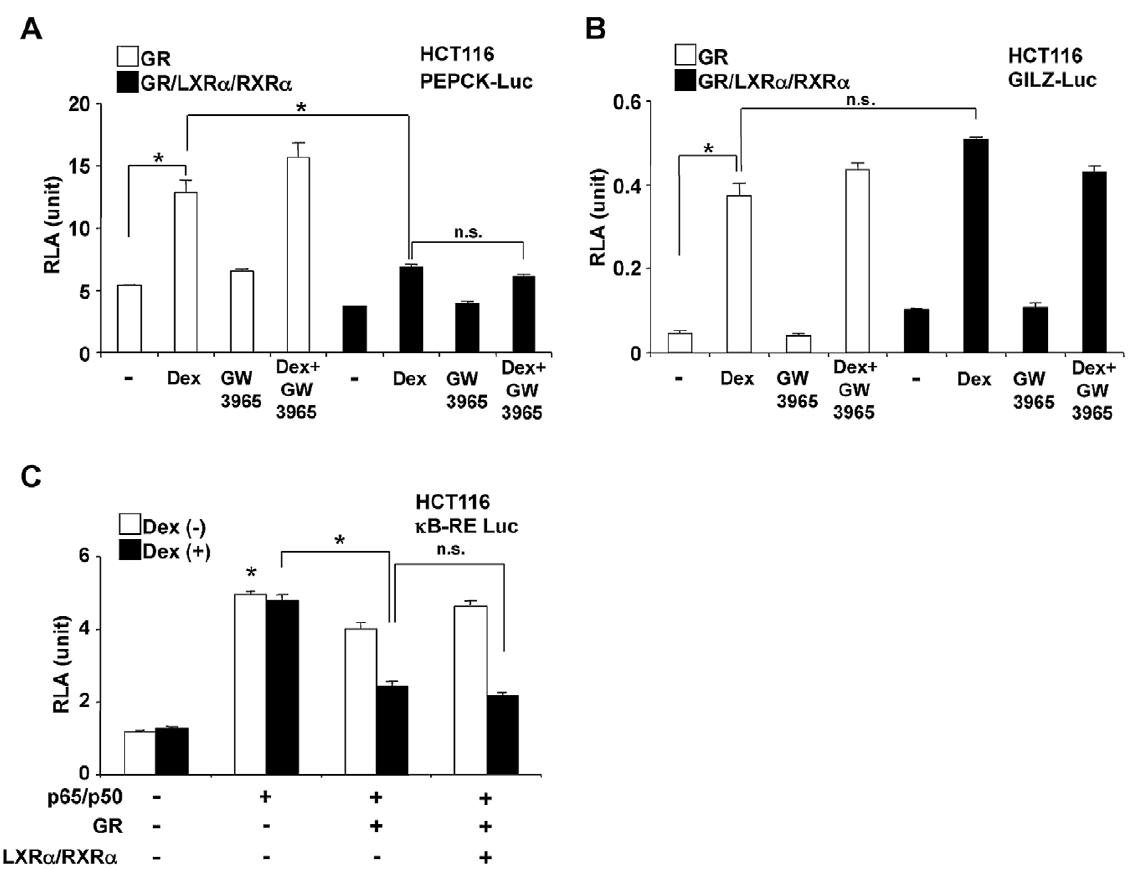
Figure 2. Over-expression of LXR a regulates dexamethasone-stimulated GR transcriptional activity in a gene promoter-specific way. A and B. Over-expression of LXR a /RXR a suppresses dexamethasone-stimulated transcriptional activity of the PEPCK (A) but not the GILZ (B) promoter. HCT116 cells were transfected with pPEPCK-luc (A) or pGILZ-Luc (B), together with pGL4.73[ hRluc /SV40] and pRShGR a in the presence or absence of pCMX-hLXR a and pCMX-hRXR a , and were incubated with or without 10 2 6 M dexamethasone and/or 10 2 6 M GW3965. Bars represent mean 6 S.E. values of the firefly luciferase activity normalized for the renilla luciferase activity. *: p , 0.01, n.s.: not significant between the two conditions indicated. Dex: dexamethasone, RLA: relative luciferase activity. C. Over-expression of LXR a /RXR a does not affect dexamethasone-induced repression of the transcriptional activity of NF- k B. HCT116 cells were transfected with ( k B) 3 -Luc and pGL4.73[ hRluc /SV40] in the presence or absence of pRSV-RelA (p65)/pRSV-NF- k BI (p50), pRShGR a , and pCMX-hLXR a and pCMX-hRXR a , and were incubated with or without 10 2 6 M dexamethasone. Bars represent mean 6 S.E. values of the firefly luciferase activity normalized for the renilla luciferase activity. *: p , 0.01, n.s.: not significant, compared to the condition obtained in the absence of p65/p50 and dexamethasone treatment, or between the two conditions indicated. Dex: dexamethasone, RLA: relative luciferase activity.